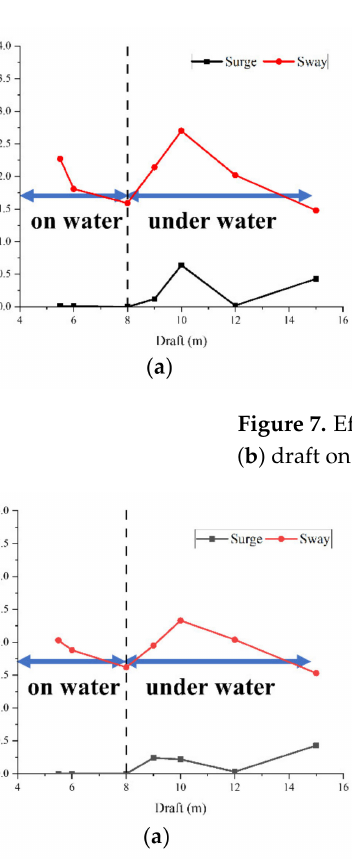
Figure 8. Effect of draft on motion amplitude and tension on eight tension legs: ( a ) surge and sway, ( b ) draft on roll, pitch, and yaw, and ( c ) maximum and average tension of tension